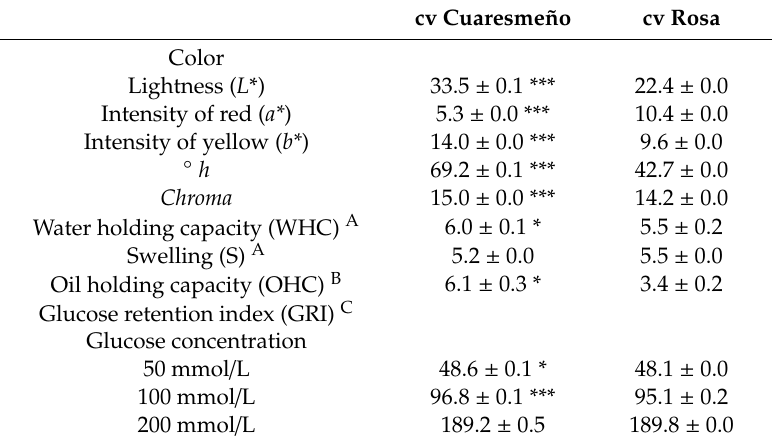
Table 3. Physicochemical characteristics of two cultivars of